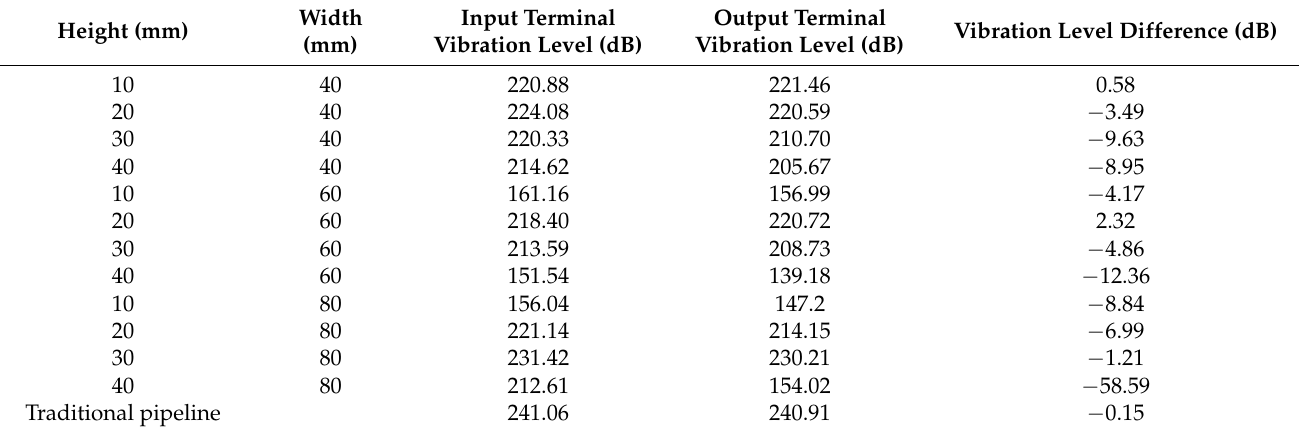
Figure 10. Common pipes. Table 3. The cushioning performance of periodic pipeline under different working conditions.